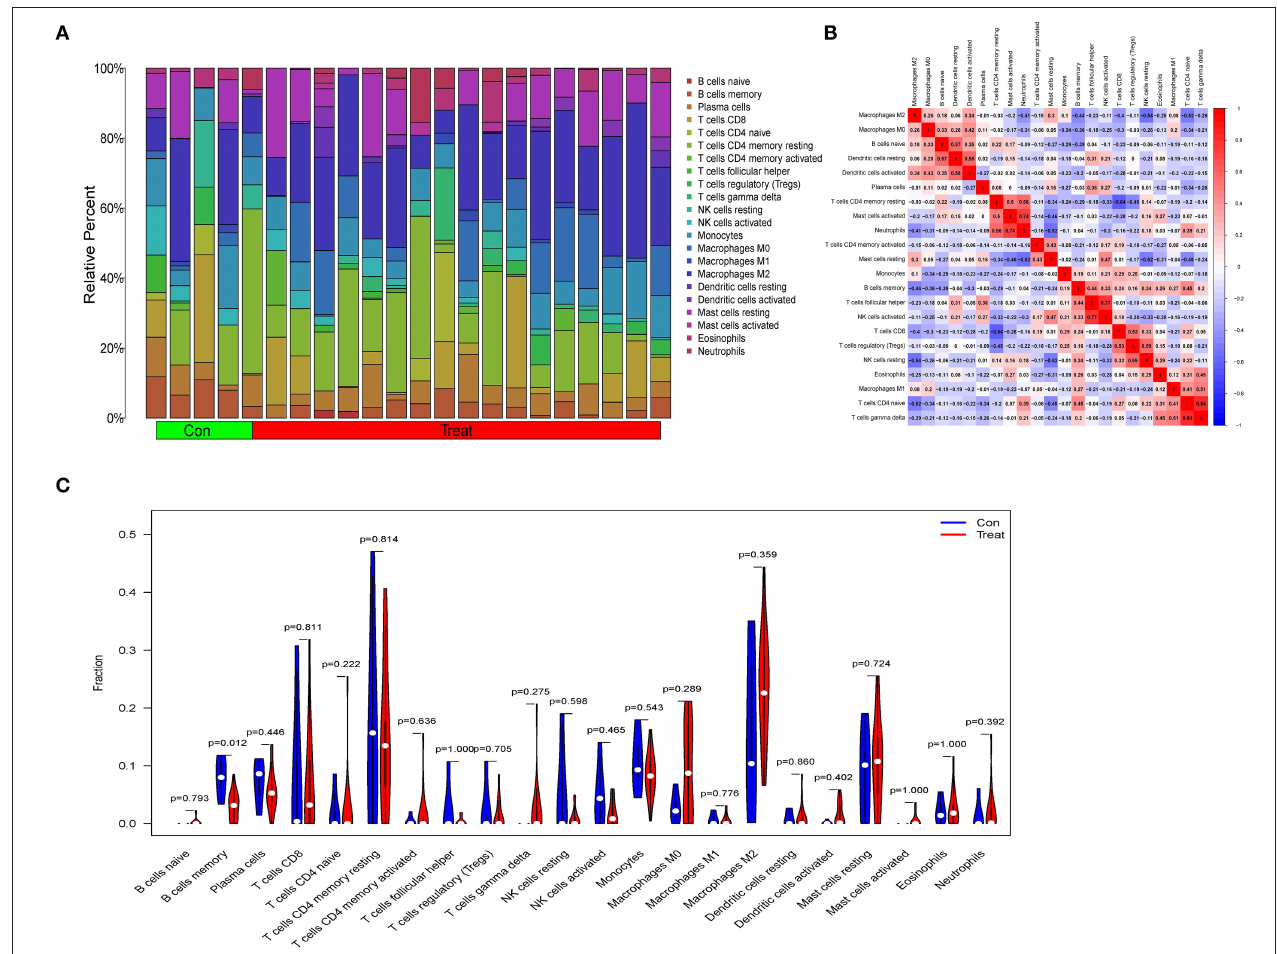
FIGURE 7 | An examination of the immunological landscape of obesity. (A) Overview of predicted proportions of 22 immune-cell categories in con and treat groups using the CIBERSORT algorithm. (B) Correlation analysis of infiltrating immune cells. (C) Con and treat groups were compared on 22 immune-cell